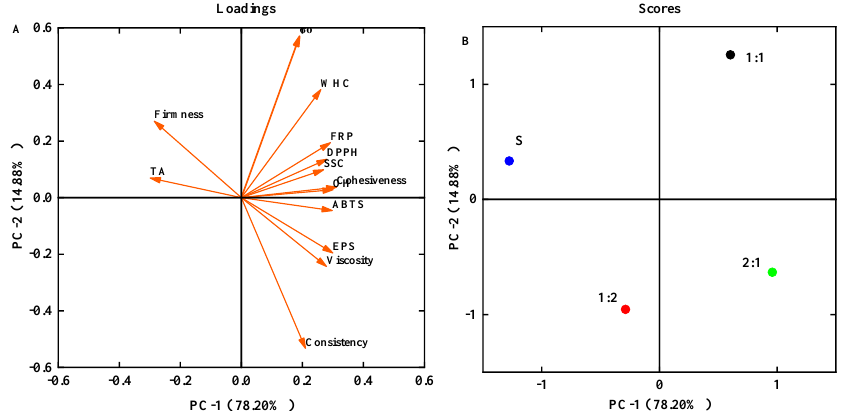
Figure 7. Principal component analysis (PCA) of all data. ( A ) Loading plot indicating the correlation between variables (EPS, apparent viscosity, firmness, consistency, cohesiveness, survival counts of S. thermophilus , DPPH, ABTS, OH, FRP, pH, TA, and WHC), EPS content, and viscosity. ( B ) Score plot indicating sample distribution based on the formulation.